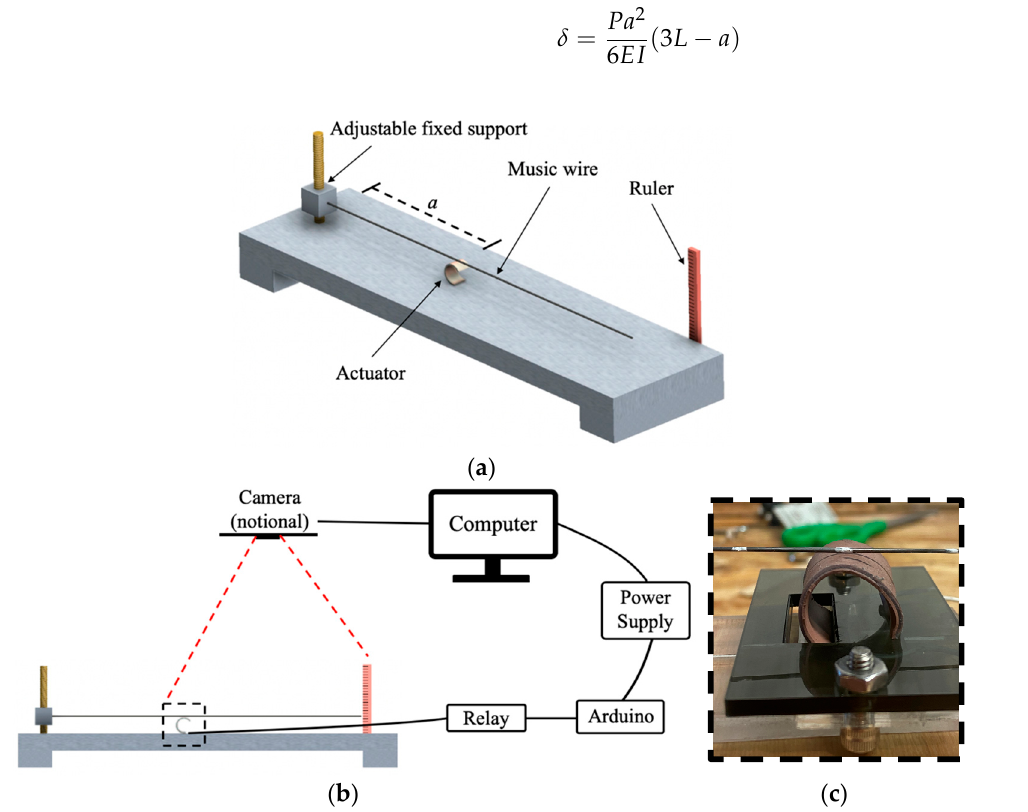
Figure 10. Efficiency test setup. ( a ) Beam rig schematic; ( b ) schematic of test setup with connections shown; ( c ) enlarged portion of ( b ) to show sample position of actuator along cantilevered beam.